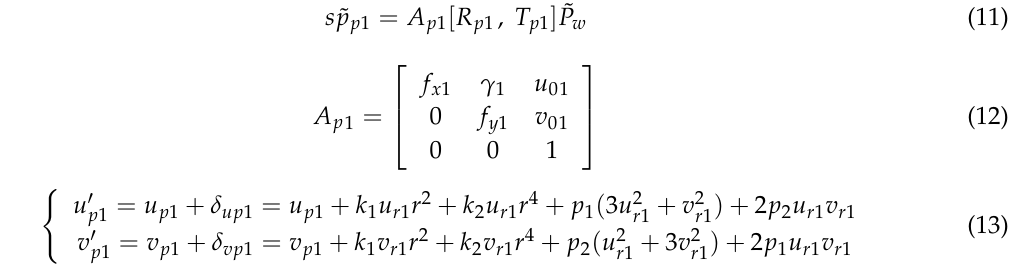
Figure 8. Model of a structured light system with an out-of-focus projector.